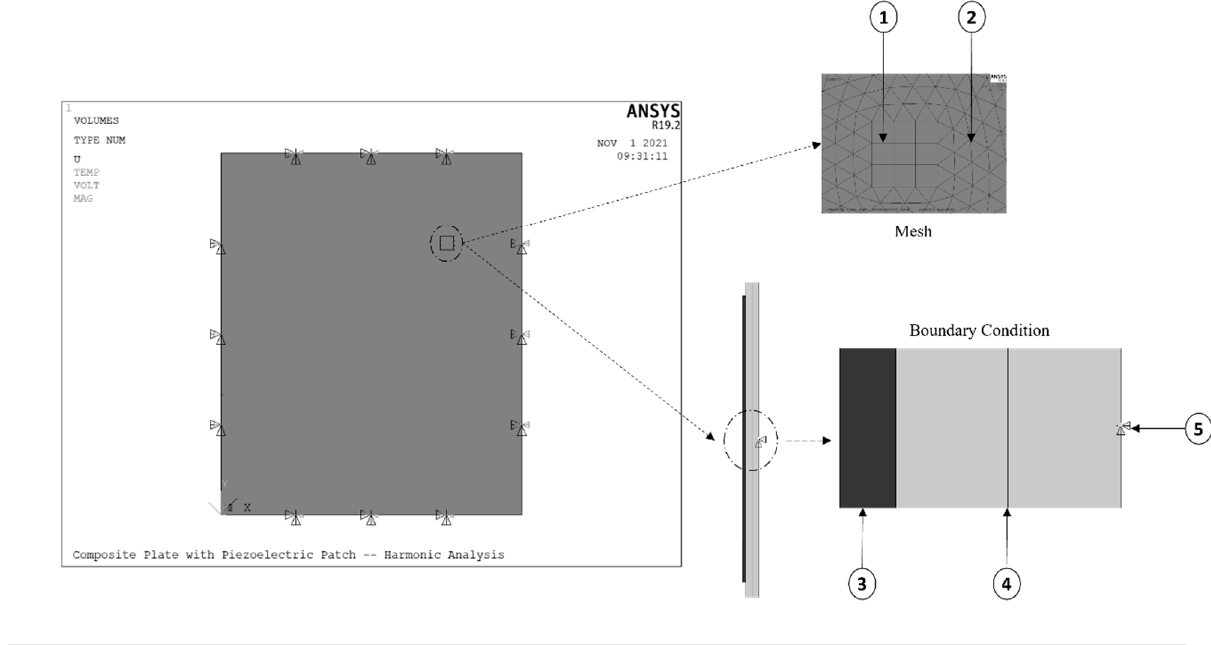
Figure 5. FE Model mesh and boundary condition.